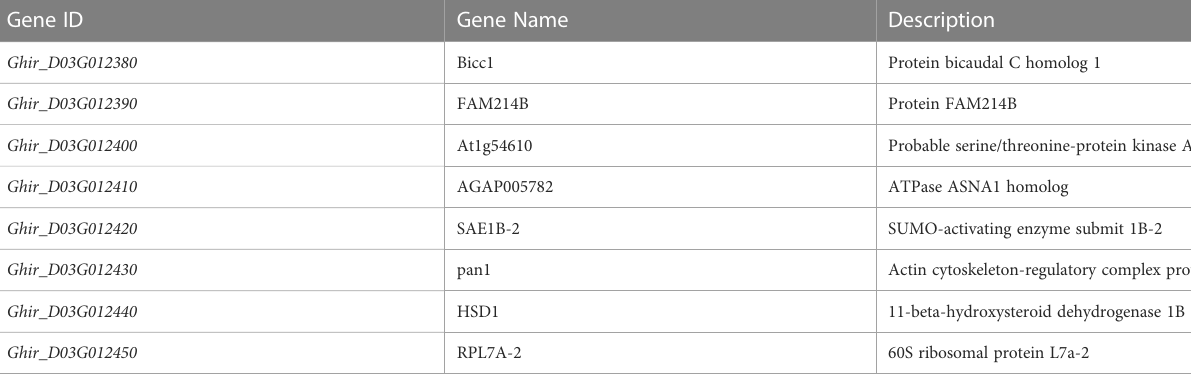
TABLE 6 The eight annotated genes in the 92.4 Kb